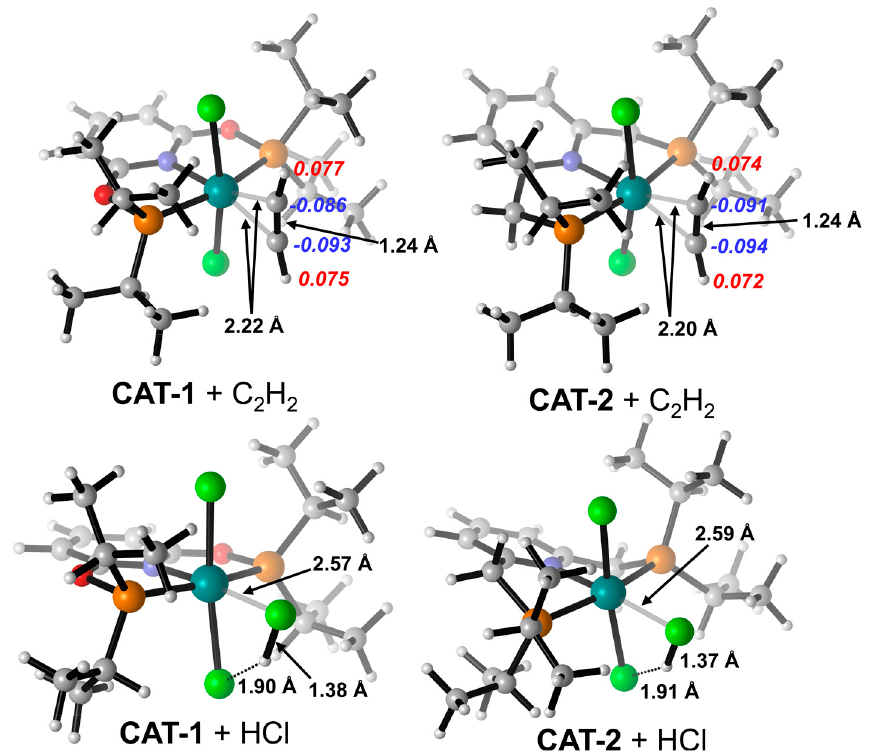
Figure 1. Optimized structures for HCl and C 2 H 2 adsorbed by CAT − 1 and CAT − 2. Key bond lengths (black numbers) and Hirshfeld charges of C 2 H 2 (red and blue numbers in Italic font) were labeled. Ball colors: green (Cl), gray (C), white (H), blue (N), red (O), orange (P), cyan (Ru).